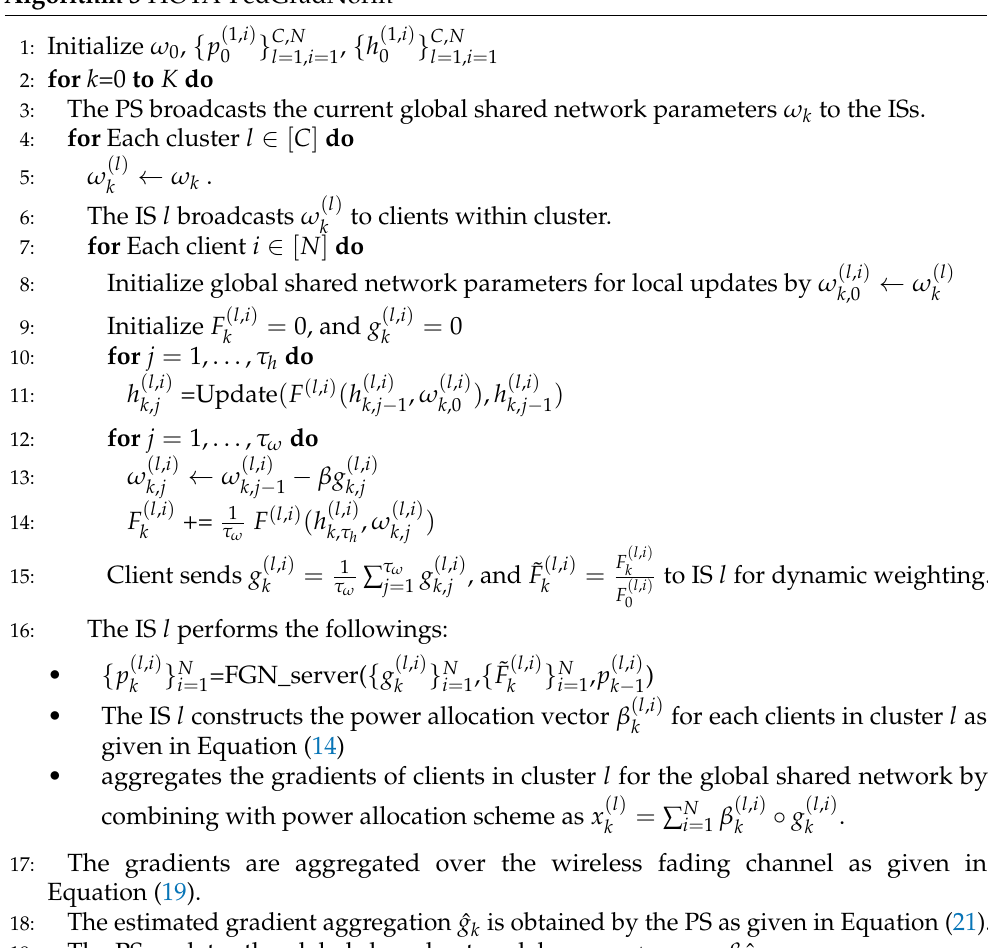
(cid:16) { ˜ F ( l , i ) } N , { g ( l , i ) } N , { p (cid:48) ( l , i ) } N i = 1 i = 1